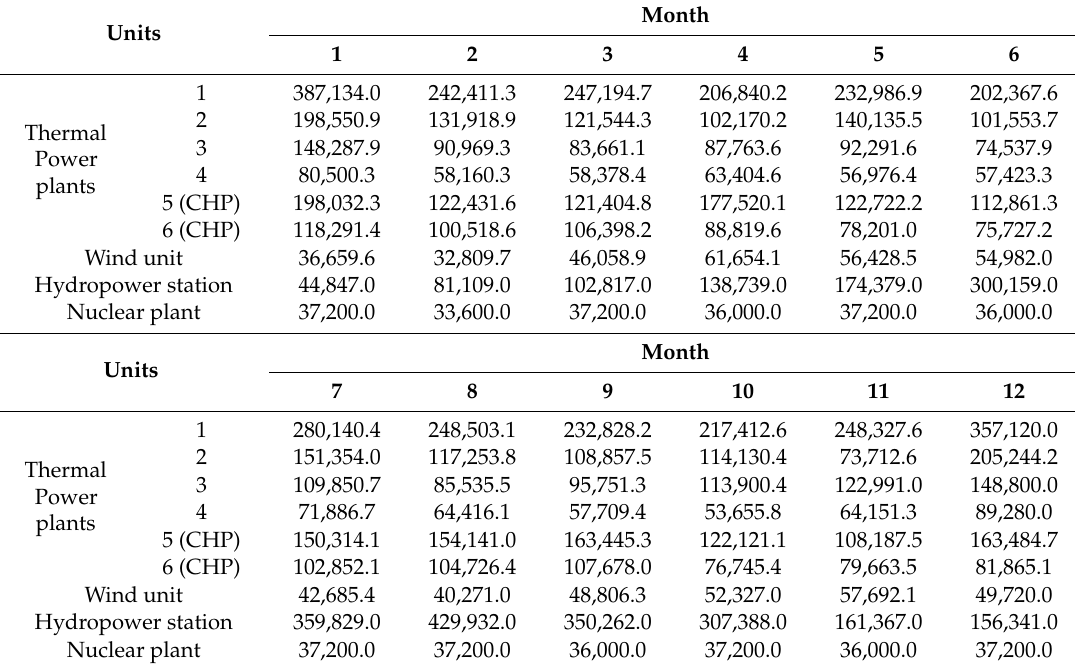
Table 13. The monthly energy-trade scheduling results for the whole